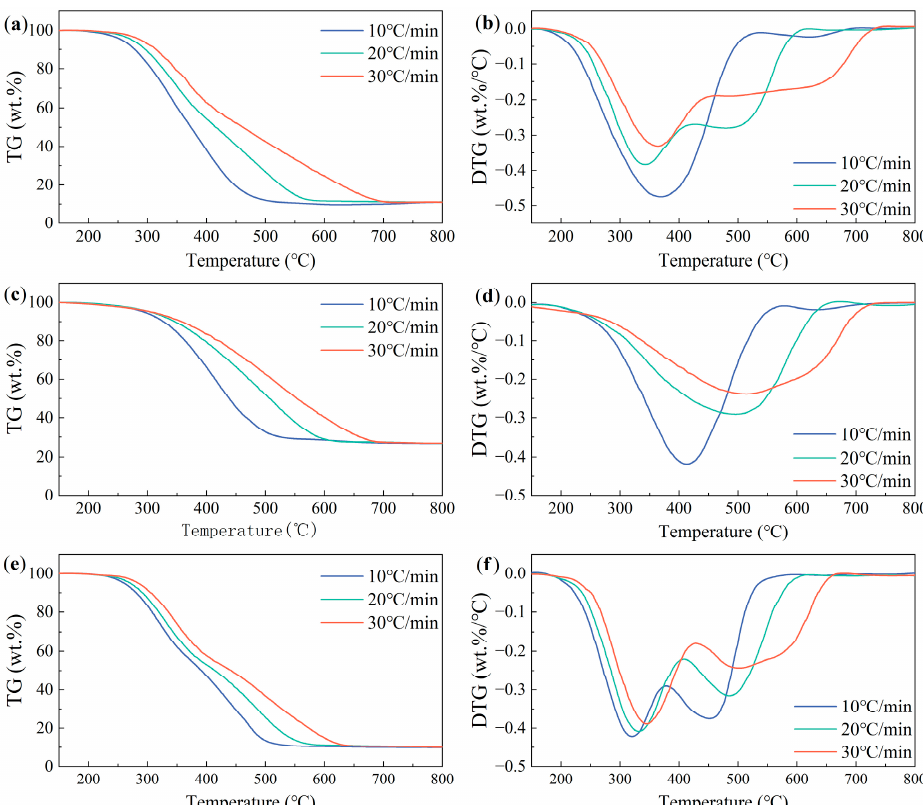
Figure 2. TG and DTG curves of ( a , b ) coal and walnut shell, ( c , d ) coal and biochar, and ( e , f ) walnut shell and biochar at different heating rates of 10, 20, and 30 °C/min. shell and biochar at different heating rates of 10, 20, and 30 ◦ Table 3. The degradation parameters of the binary blends.